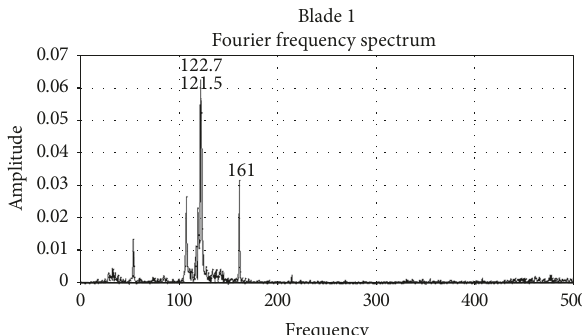
Figure 4: Fourier spectrum with air flow: blade 1, event A.